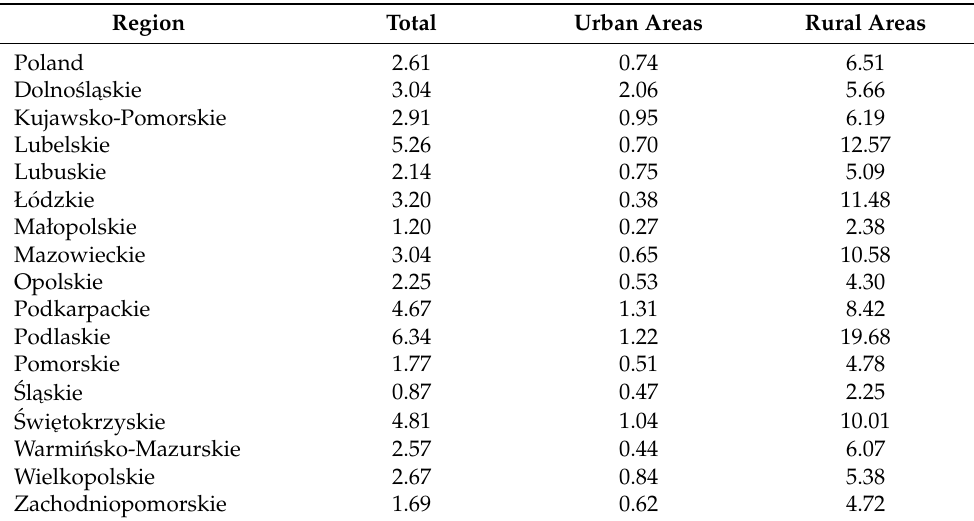
Table 4. The rate of change in electricity consumption in households in Poland in the years 2004–2019 (%).